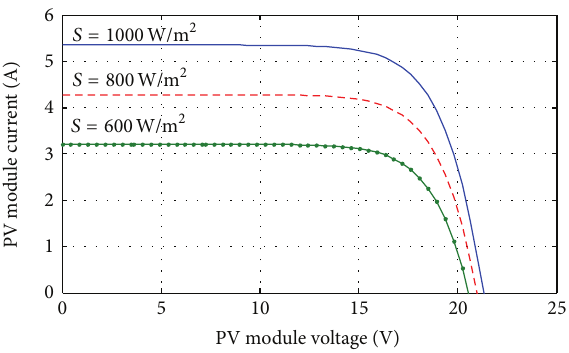
Figure 3: KOYCERA KC85T-87W PV model I-V characteristics curve with varying irradiation.